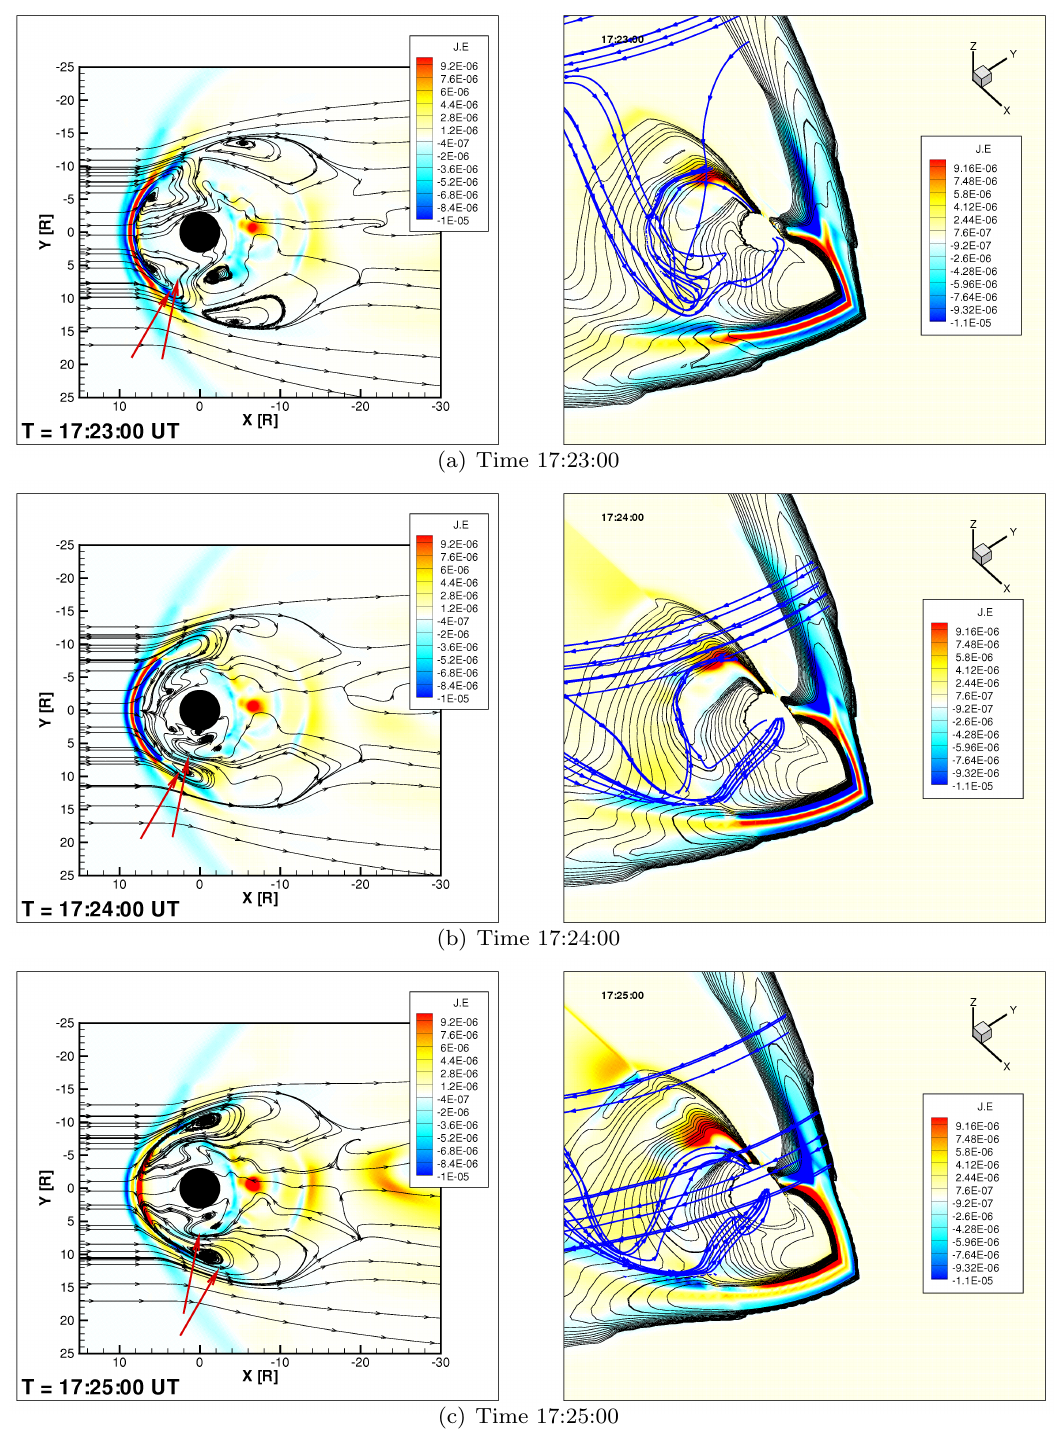
Fig. 9. Southward IMF condition: left column shows the plasma convection (streamlines) in the equatorial plane, with the contour repre- senting J · E ; right column shows the 3-D current flow in the same format as in the right column of Fig.